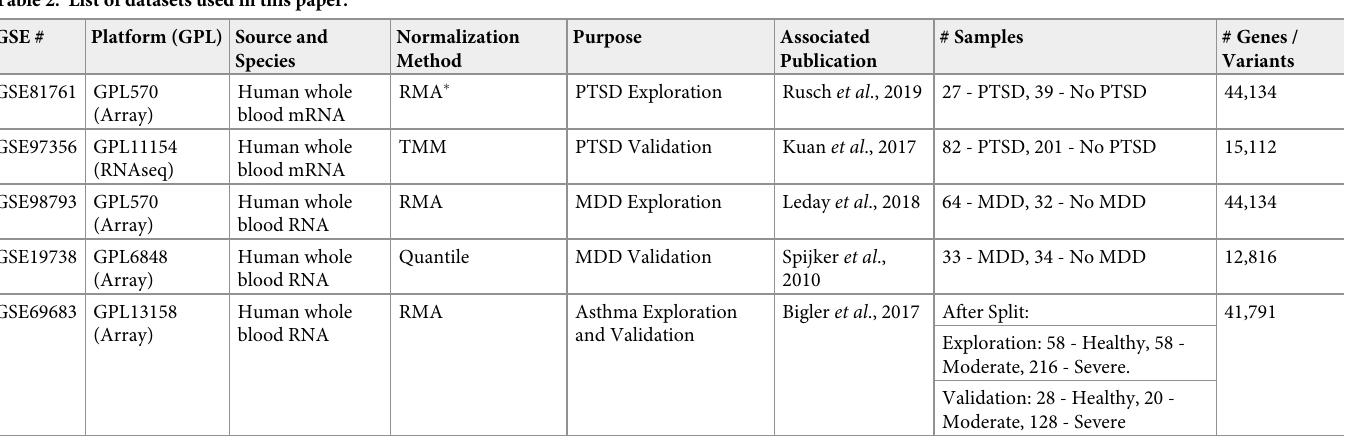
Table 2. List of datasets used in this paper.